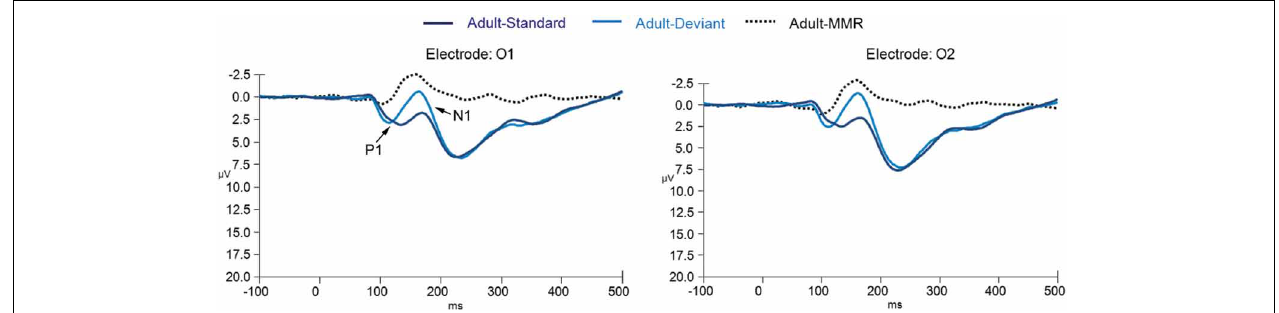
FIGURE 3 | ERPs for deviant non-target and standard non-target stimulus conditions as well as the difference wave computed by subtracting standard non-target from deviant non-target ERPs in adults ( N = 20) at electrode positions F3, Fz, F4, C3, Cz, C4, P3, Pz, and P4.